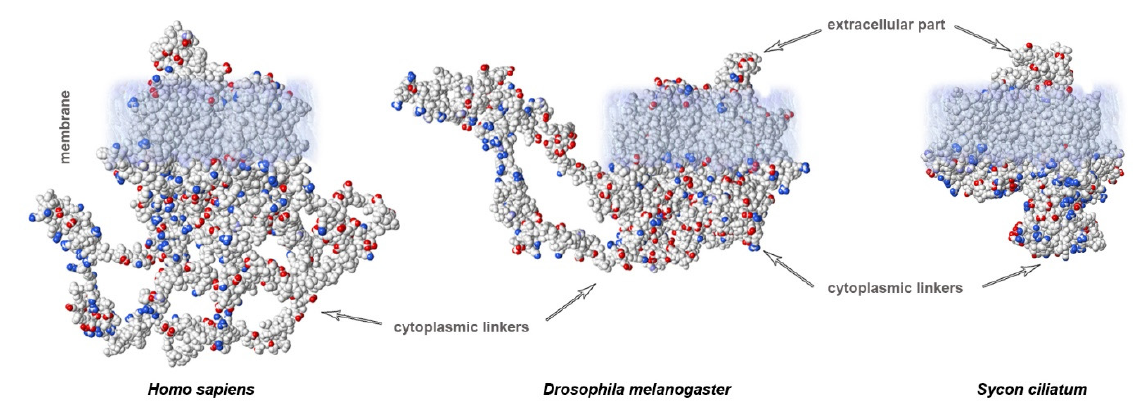
Figure 3. Calculated electrostatic potentials reveal different lengths of cytoplasmic linkers of NaV channels: mammals (H. sapiens) show the longest linkers compared to those of insects ( Drosophila ) or sponges ( Sycon ). Sequences obtained from GenBank.